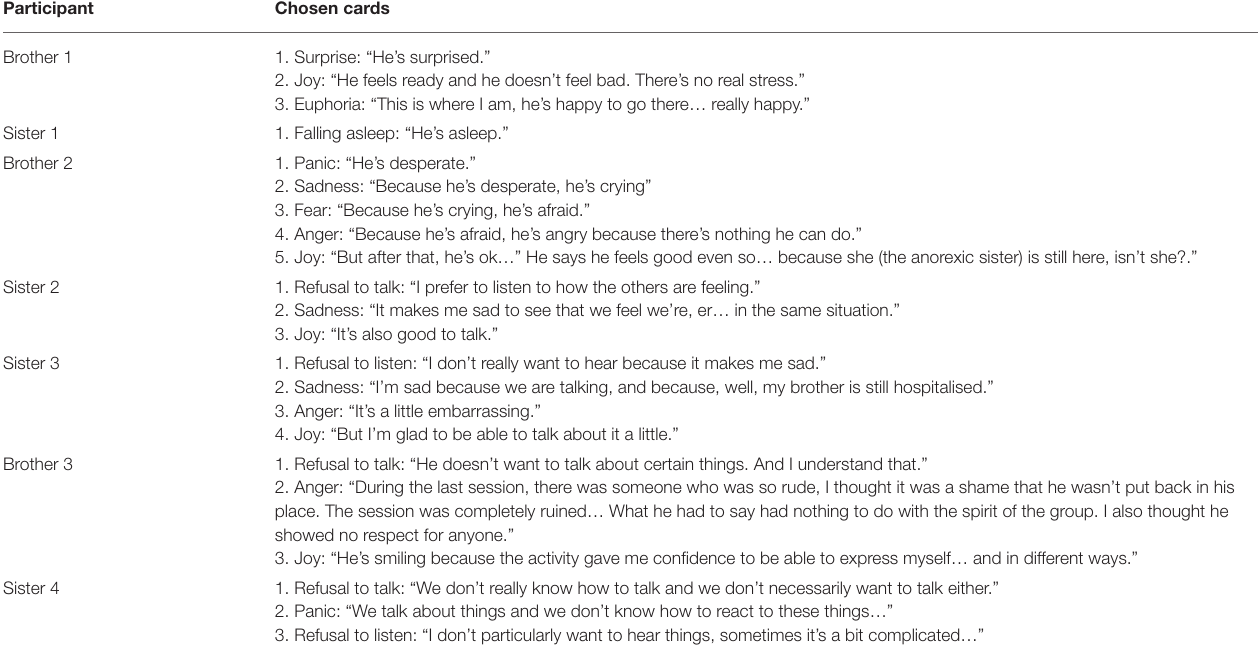
TABLE 3 | Analysis of the ludic support: ≪ Set of Emoji cards ≫ . Participant